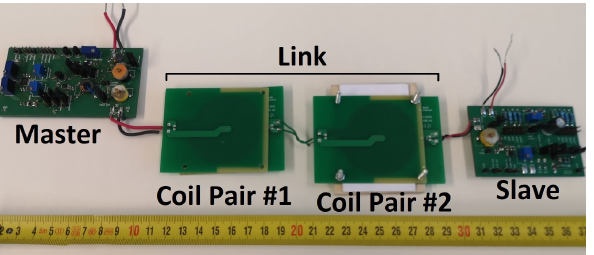
Figure 12. Image of the prototype. In this picture, coil pair #2 is placed in a holder with a fixed spacing, and coil pair #1 is loose.